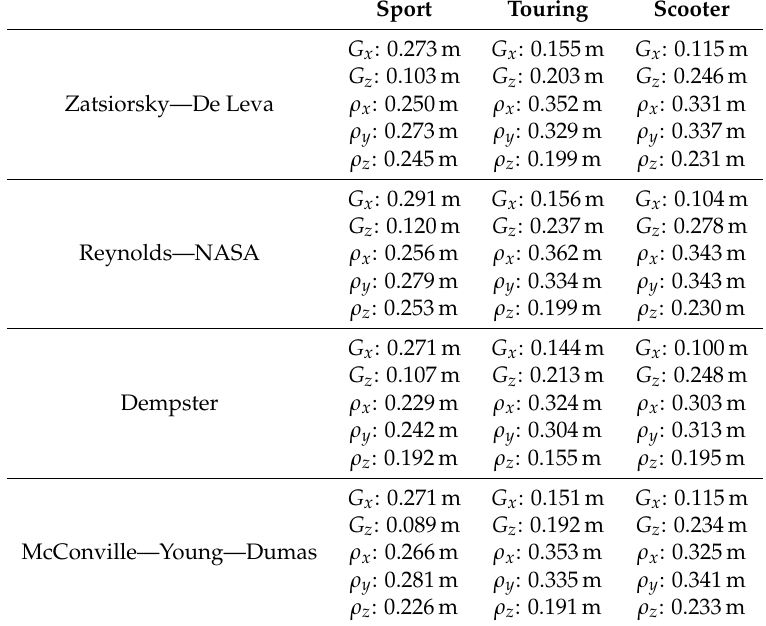
Table 3. Typical rider parameters for sport, touring, and scooter postures. G coordinates are given with respect to the saddle reference